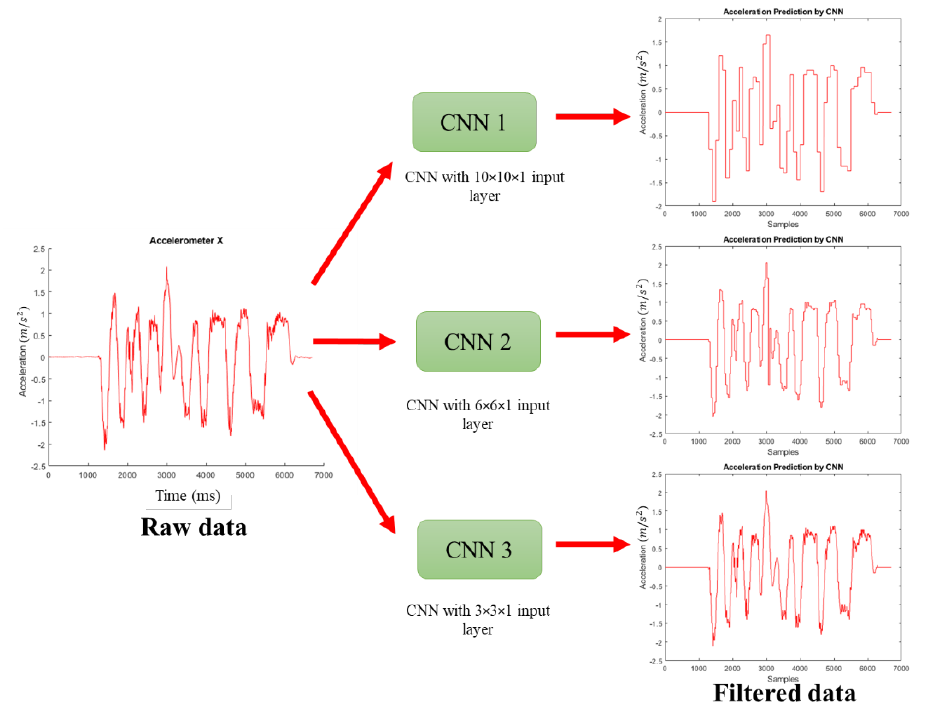
Figure 3. Sampled IMU outputs filtered by Deep Learning implementation.